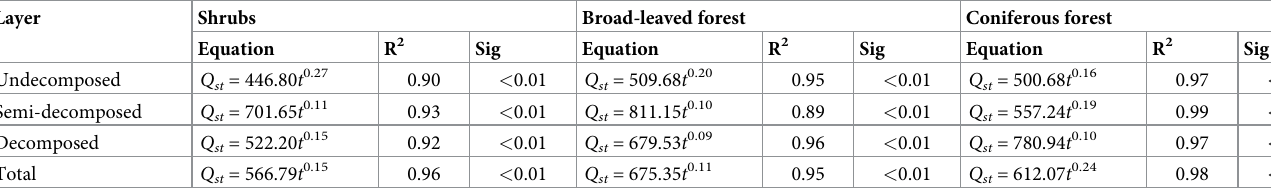
Table 2. The regression equation of the litter water-releasing capacity( Q st ) and time( t ).